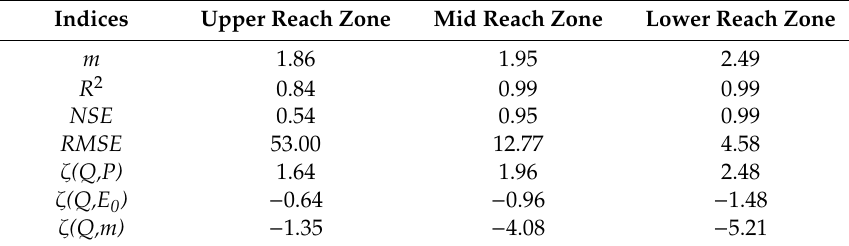
Table 2. Simulation accuracy of E and elasticity of runo ff to changes in climatic and other factors across the Urumqi River basin.